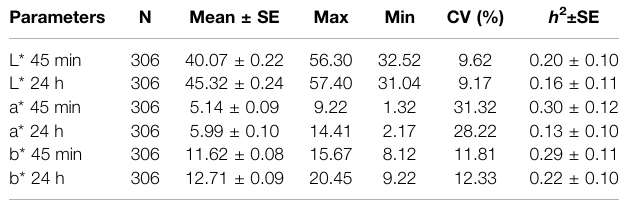
TABLE 2 | Descriptive statistics of meat